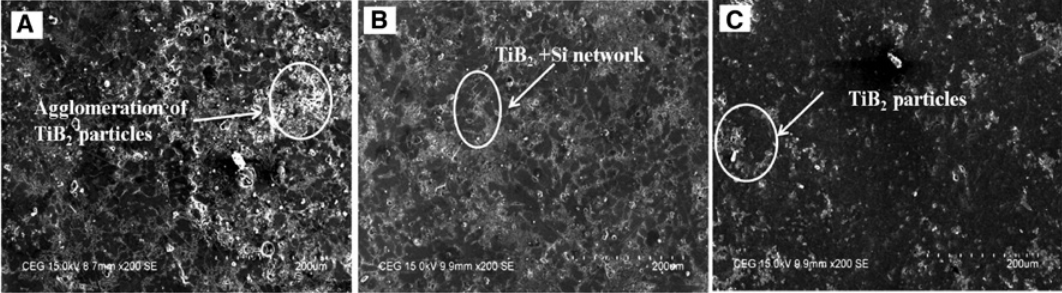
composites fabricated at 20 min AT and HTs of (A) 20 min (B) 30 min, and (C) 40 min. Figure 3: Microstructures of the Al/TiB 2